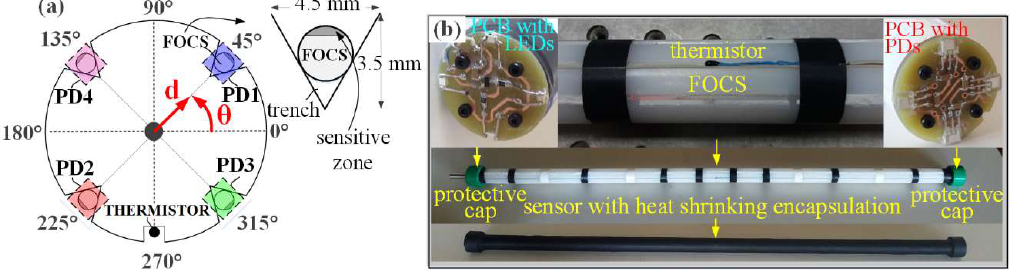
Figure 1. ( a ) Arrangement of the FOCSs and PDs at beam cross section in respect to the reference coordinate system; ( b ) Photo of the fabricated sensor.